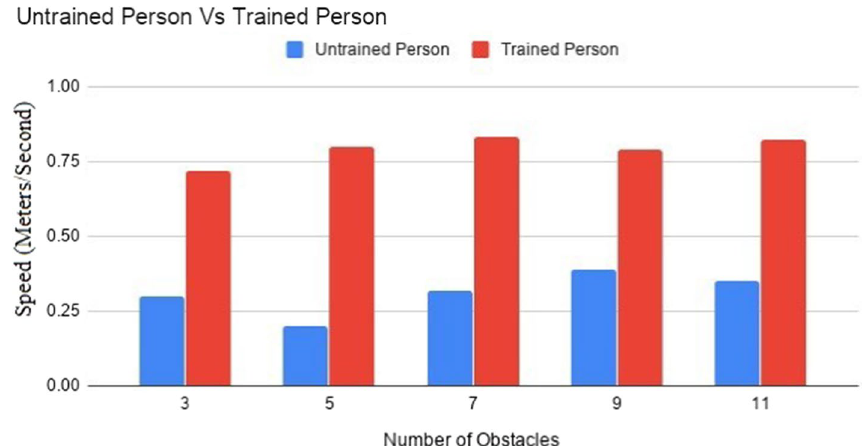
Fig. 16 Performance and accuracy of blind’s